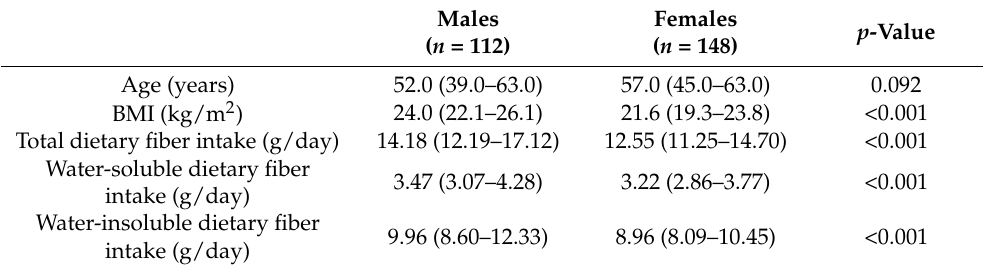
Table 4. Participants’ characteristics of Group H 1 .